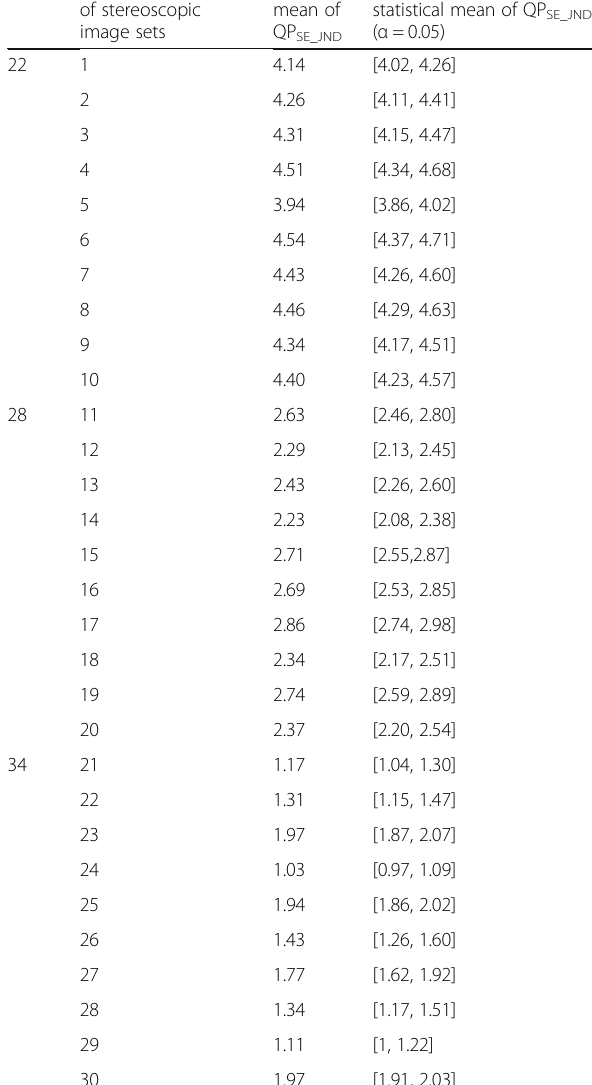
Table 7 QP SE_JND of each group of stereoscopic image set for symmetric coding QP REF The index 30 groups of stereoscopic image